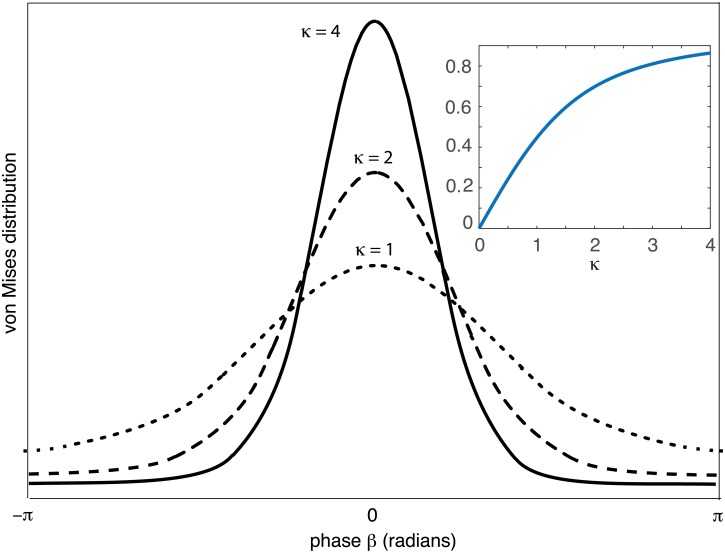
Sample plots of the von Mises distribution M(β, 0, κ) centered at zero for various values of κ.Inset: Plot of first circular moment I1(κ)/I0(κ).